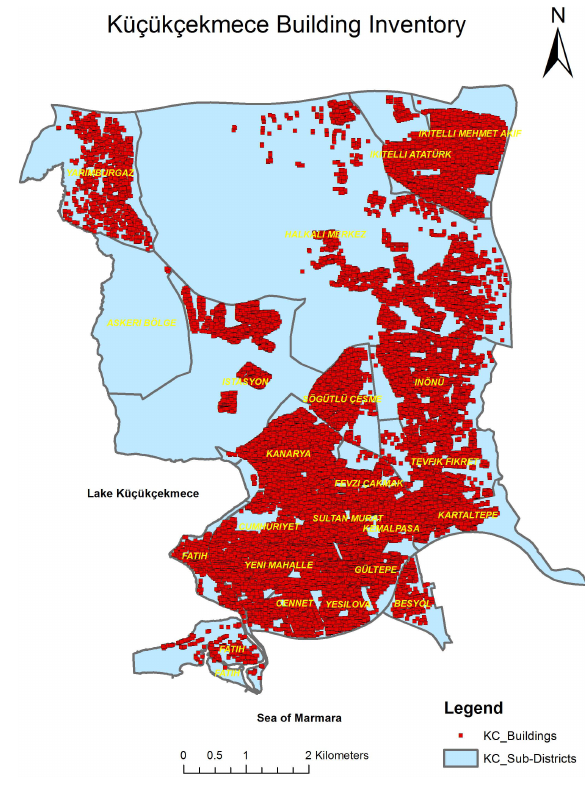
Fig. 5. Küçükçekmece building